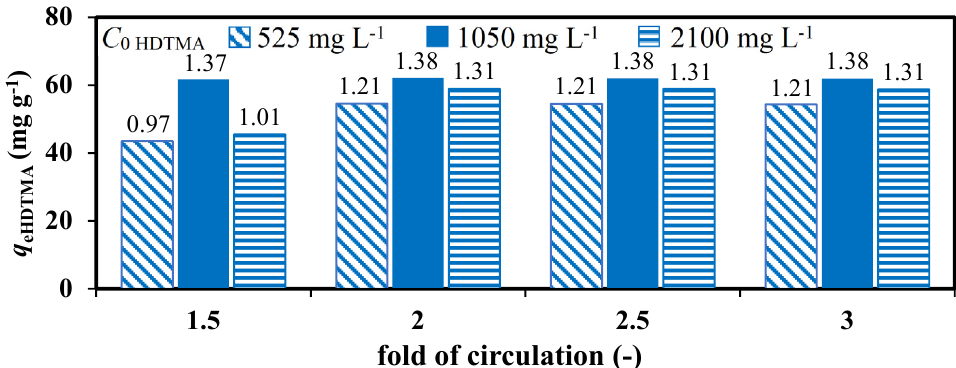
Figure 1. Influence of the type of circulation unit and surfactant solution flow rate on efficiency of CL modification. DC values over the bars. C 0 HDTMA = 1050 mg L − 1 , T = 25 °C, x = 2 ECEC.